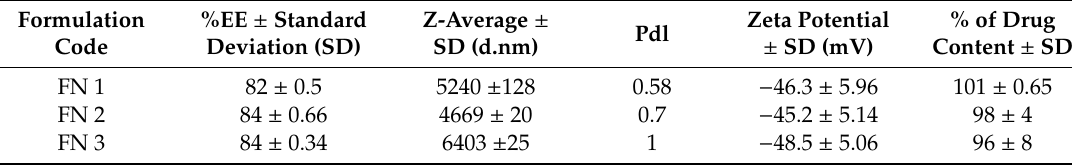
Table 4. Illustration of different characterization of the niosomes derived from proniosomes, which includes the % of entrapment efficiency, size of the formed niosomes in nm, their Pdl and Zeta potential, and the % of the drug content in the niosomal suspensions formed. Formulation Code